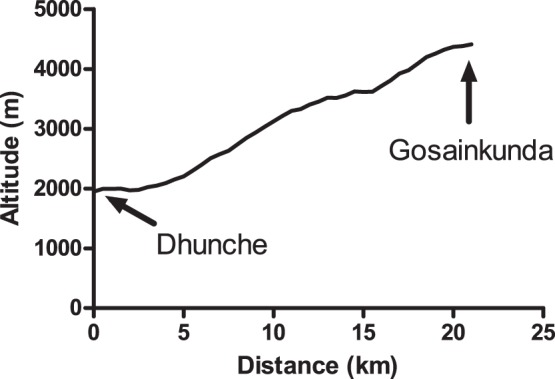
The ascent profile from Dhunche (1950 m) to Gosainkunda (4380 m).All subjects ascended to Gosainkunda via this route in 1, 2, or 3 days. The average grade of the ascent was approximately 12%.